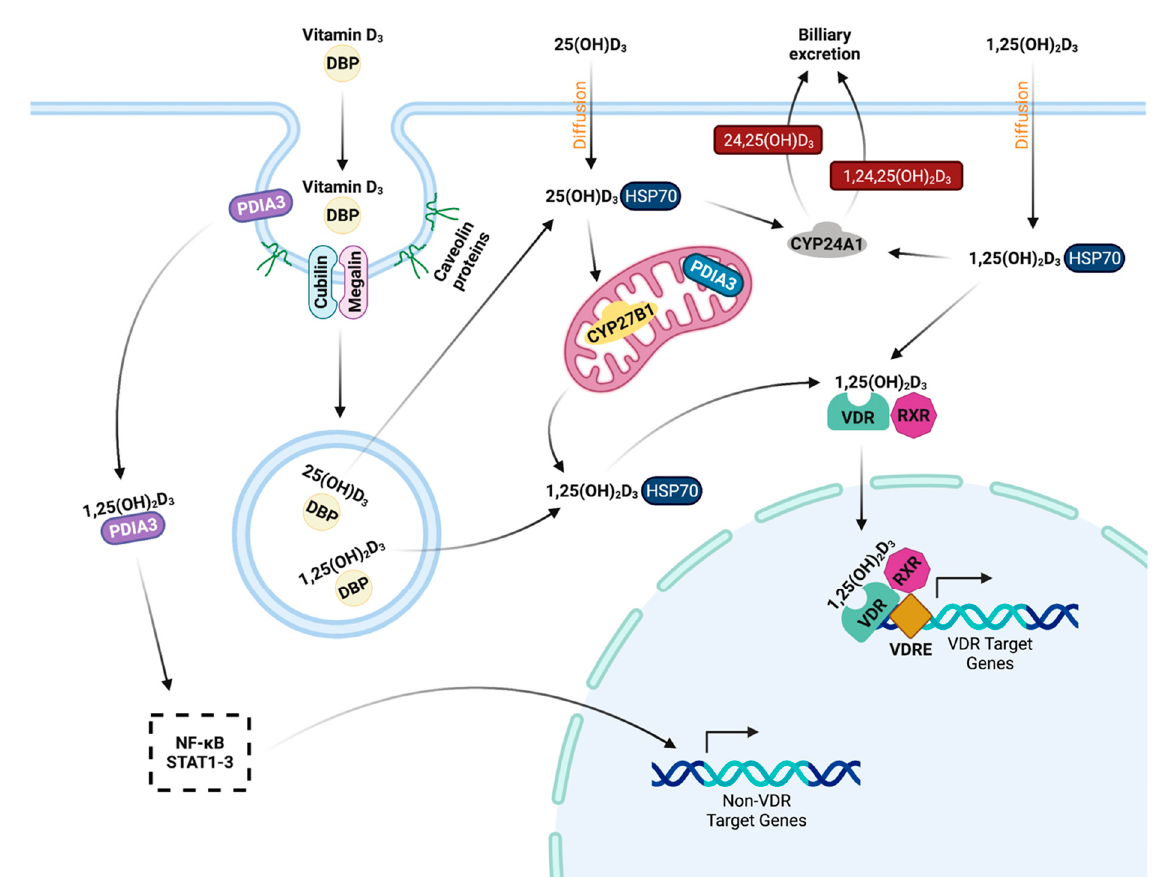
Figure 2. 25(OH)D 3 and 1,25(OH) 2 D 3 travel in the circulation mainly bound to vitamin D binding protein (DBP). They are taken up by caveolae mediated endocytosis, where DBP then disassociates. Free 25(OH)D 3 and 1,25(OH) 2 D 3 are lipophilic and can diffuse across the cell membrane. 25(OH)D 3 is activated by 1 α -OHase (CYP27B1) in the mitochondria. Activated 1,25(OH) 2 D 3 binds the